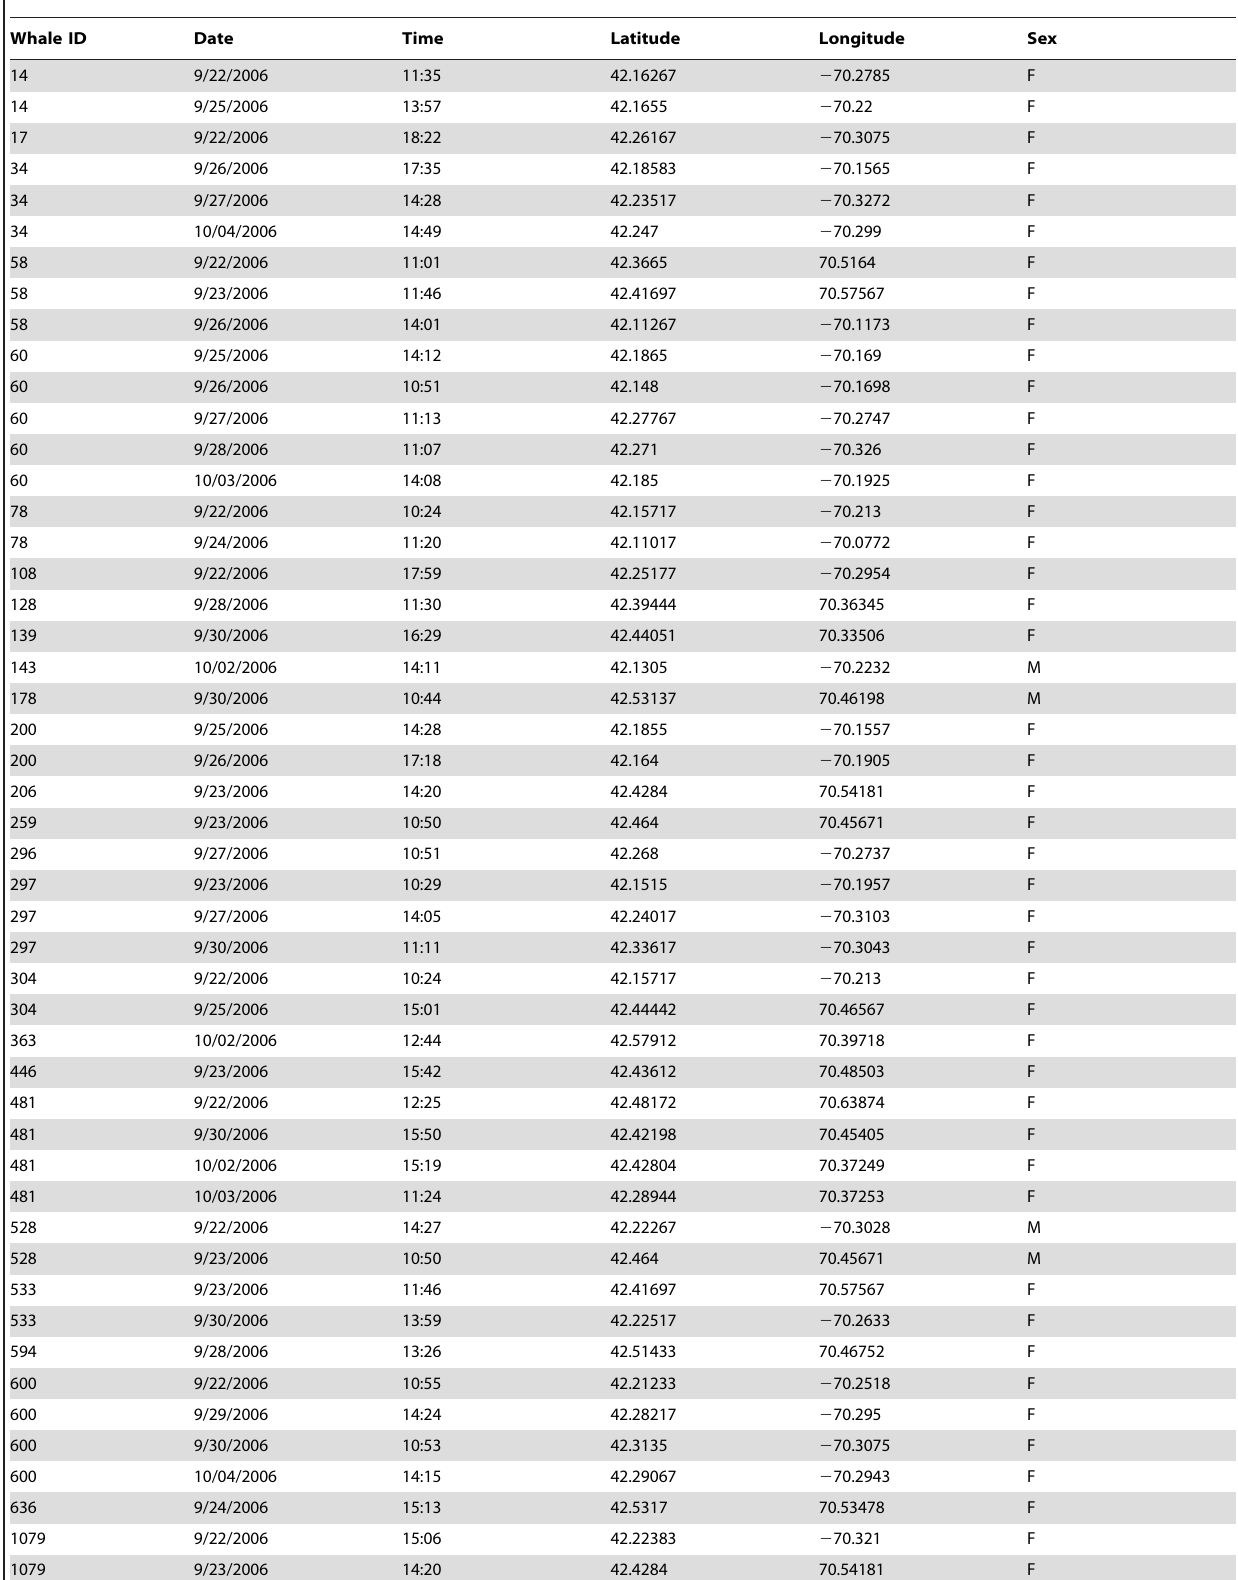
Table 1. Sightings of individually identified humpback whales by sex (one location/day; dependent calves excluded) in the Stellwagen Bank area from September 22 to October 6, 2006.